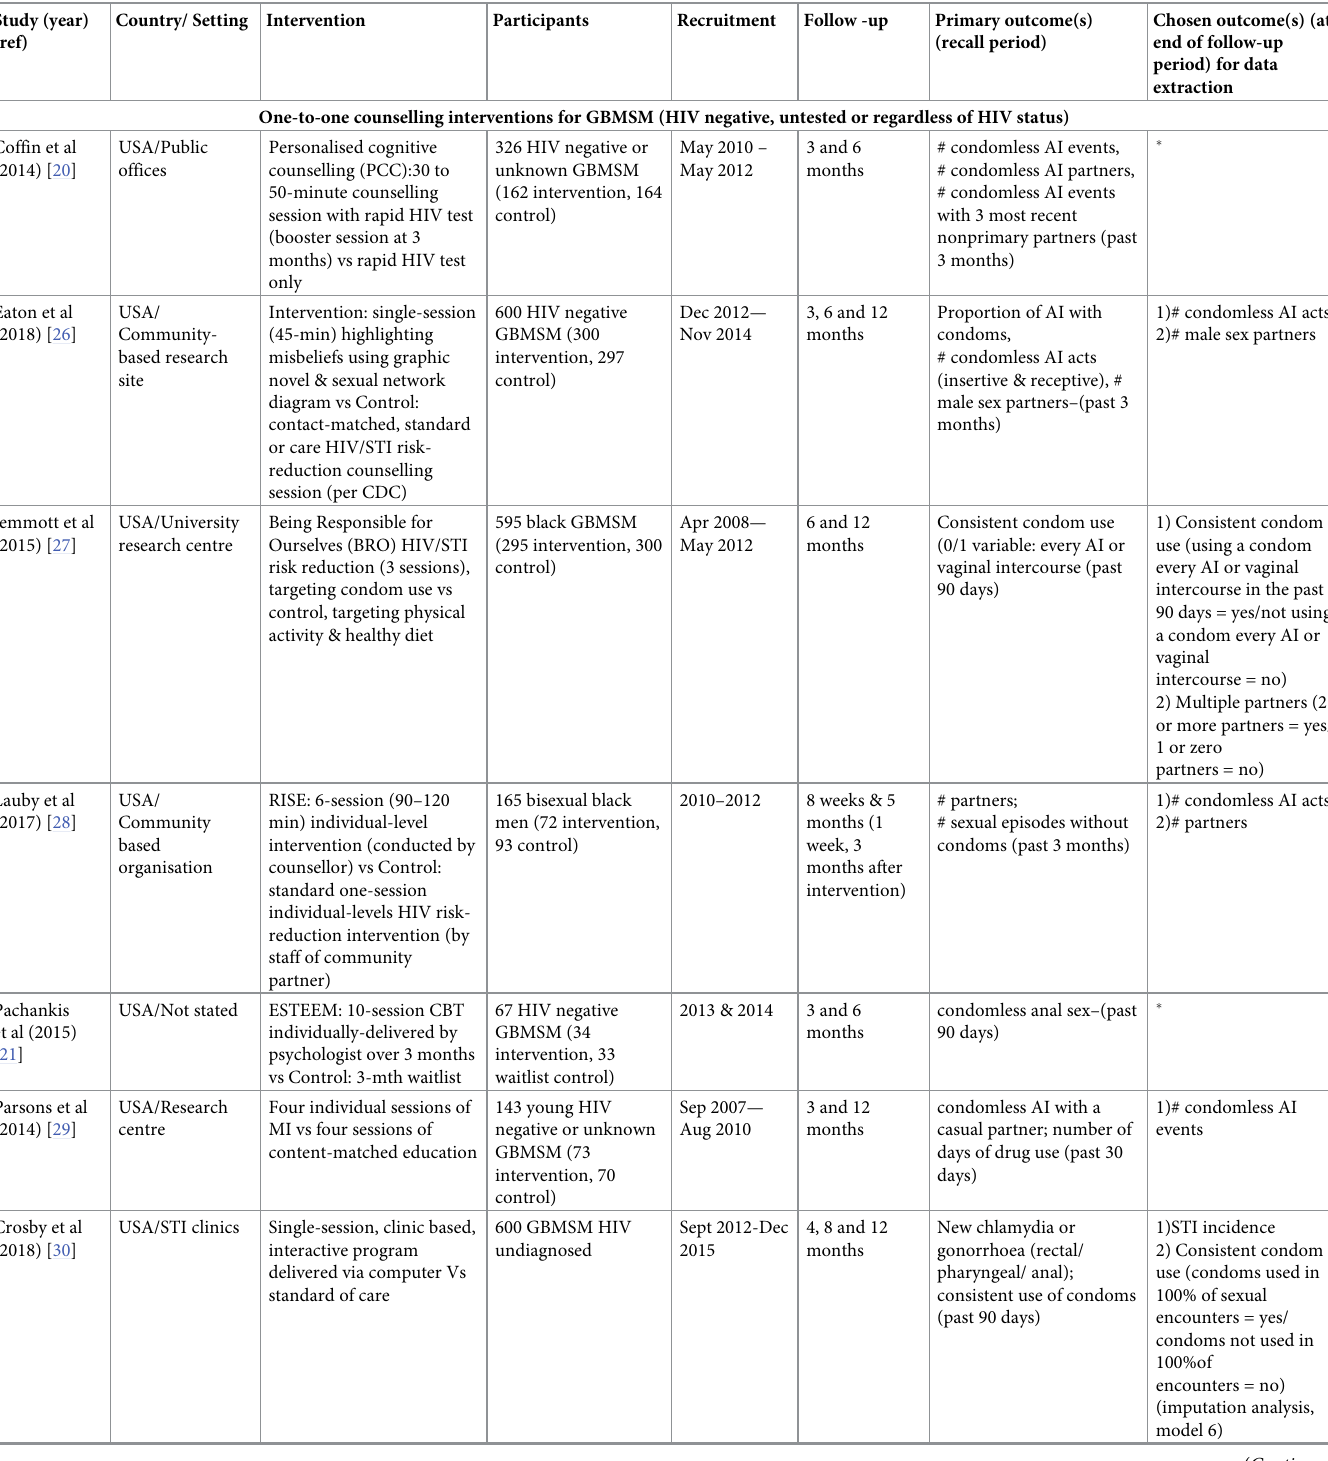
Table 1. Study characteristics of randomised controlled trials included in this review, grouped by intervention type. Study (year) Country/ Setting (ref)